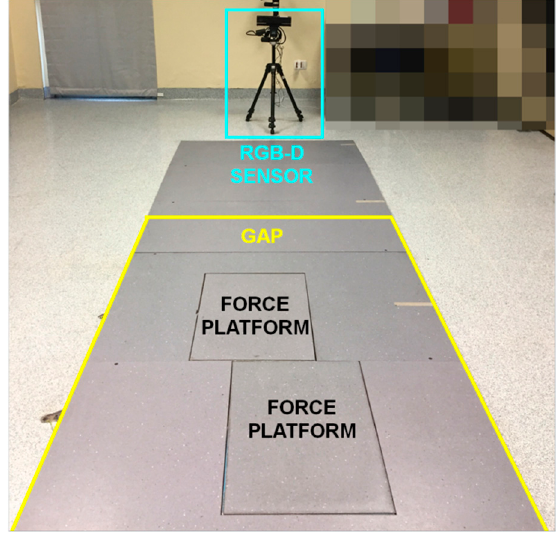
Figure 1. Experimental setup: position of the RGB-D sensor (light blue square); position of the force platform for 3D-GA system; approximate position of the final area of the Gait Analysis Path on the walkway for RGB-D system (yellow lines).